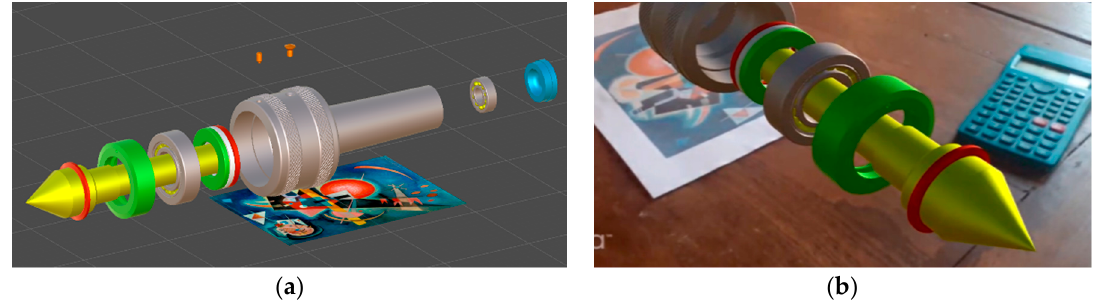
Figure 9. ( a ) Exploded view of the assembly on Unity; ( b ) AR camera view.